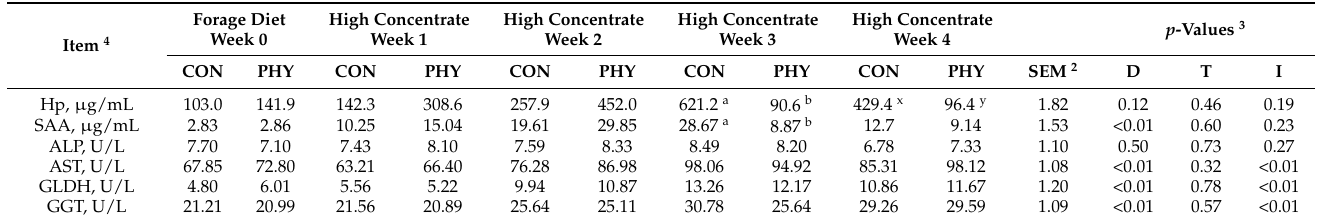
Table 4. Effect of supplementation with a phytogenic feed additive based on L-menthol, thymol, eugenol, mint oil ( Mentha arvensis ) and cloves powder ( Syzygium aromaticum ) on liver enzymes and acute phase proteins in cows consuming a forage diet or a high concentrate diet 1